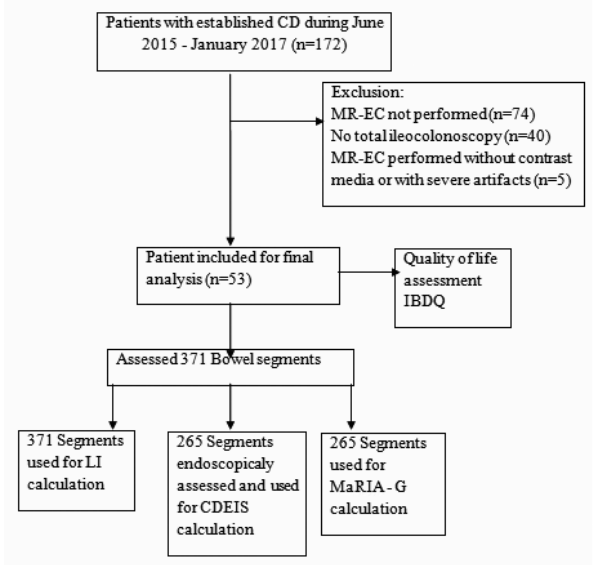
Figure 1: Flowchart of patient enrollment, exclusion criteria, and final study